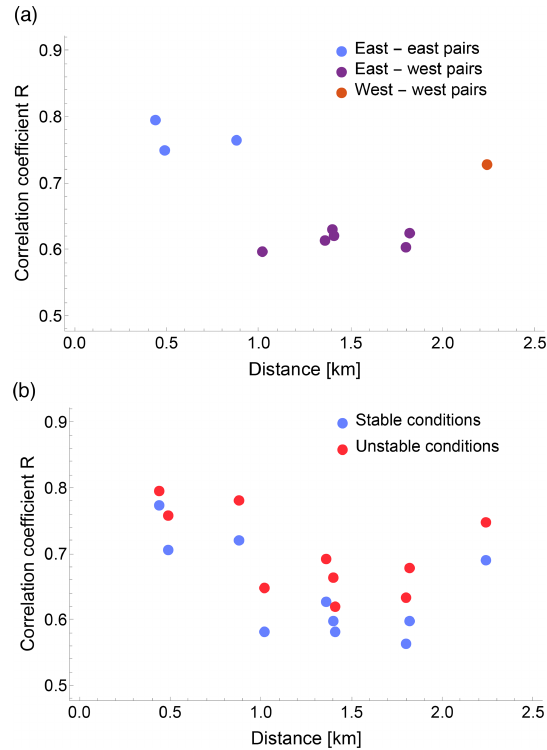
Figure 6. Correlation coefficient R between log ((cid:15)) from different pairs of 10m sonic anemometers at the Physics Site as a function of the separation between the single meteorological towers. (a) Differ- ent colors are used for pairs of towers both on the western side of the Physics Site, both on the eastern side, or on both sides. (b) Data points are classified as a function of atmospheric